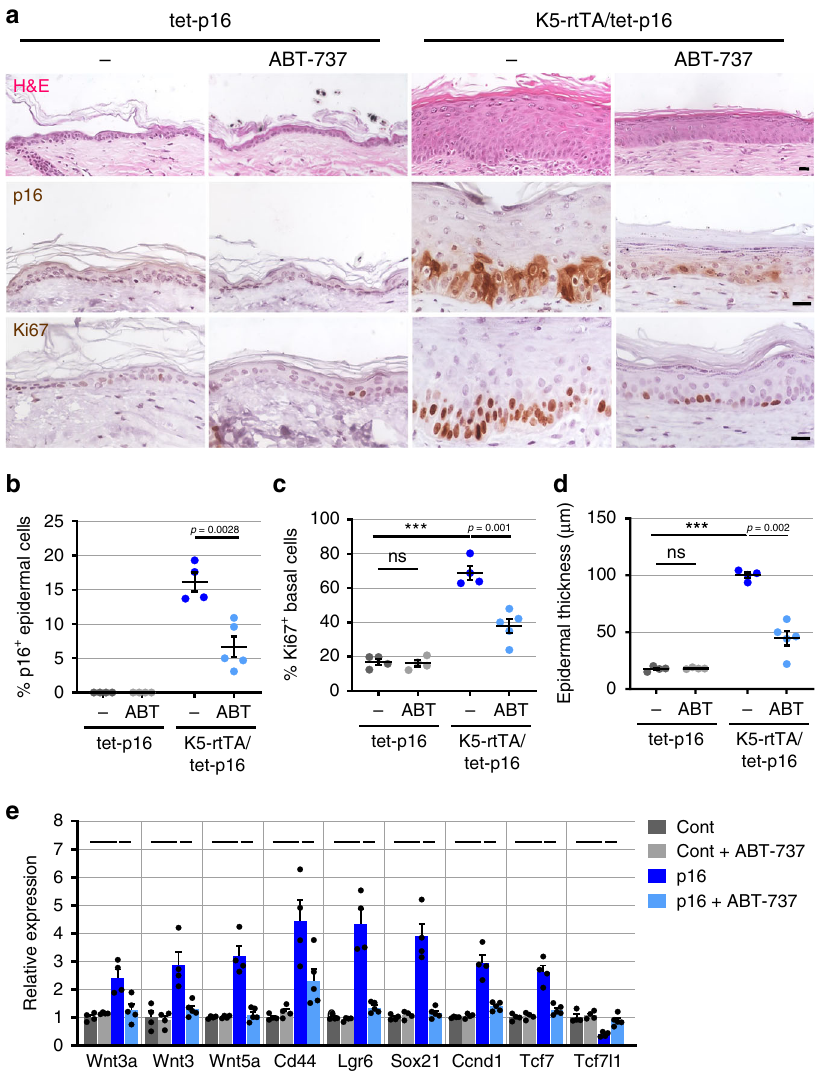
Fig. 7 Senolytic treatment inhibits p16-induced hyperplasia and Wnt activation. a Skin sections from K5-rtTA/tet-p16 and control tet-p16 mice treated with dox for 6 months and subsequently treated with ABT-737 (6 injections over 9 days), stained by H&E, for p16, or for Ki67. b Percentage of p16 + IFE cells in ABT-737-treated and untreated p16-induced and control mice (dots). c Percentage of Ki67 + basal IFE cells in same mice. d Epidermal thickness in same mice. e Relative mRNA levels of the indicated Wnt-pathway-associated genes in whole skins isolated from the same mice, measured by qRT-PCR. P < 0.05 for all comparisons indicated by lines: p16 versus control (dark blue versus dark grey, long lines) and p16 + ABT-737 versus p16 (light blue versus dark blue, short lines). n = 4, 4, 4, 5 in respective groups in all panels. All graphs indicate mean values across mice ± S.E.M. Scores were conducted visually from images. *** P < 0.0001, t test. Scale bars — 20 μ